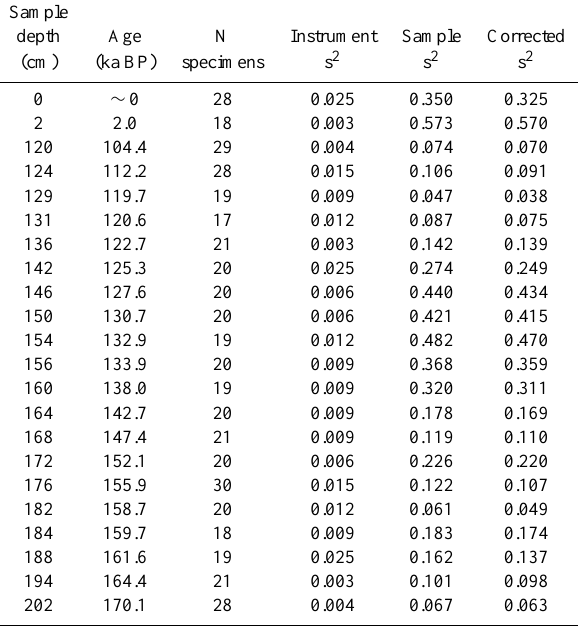
Table 1. Result of G. truncatulinoides sin. individual isotope mea- surements, and estimation of sample variability, with the respective correction (see